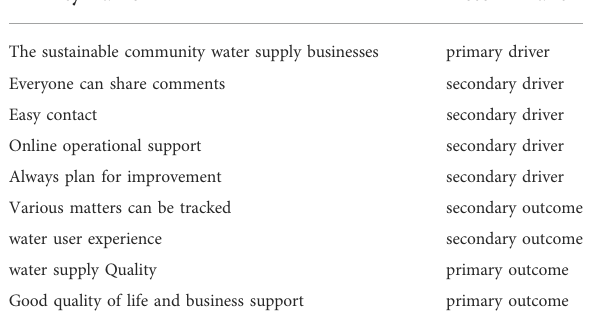
TABLE 10 Af fi nity name and determinant.